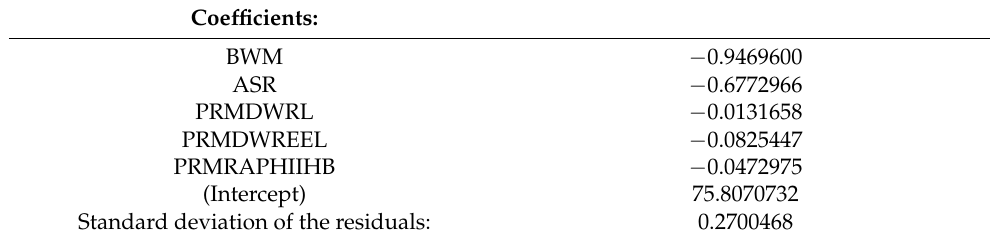
Table 5. Parameters of node “private renters” (Gaussian distribution; conditional